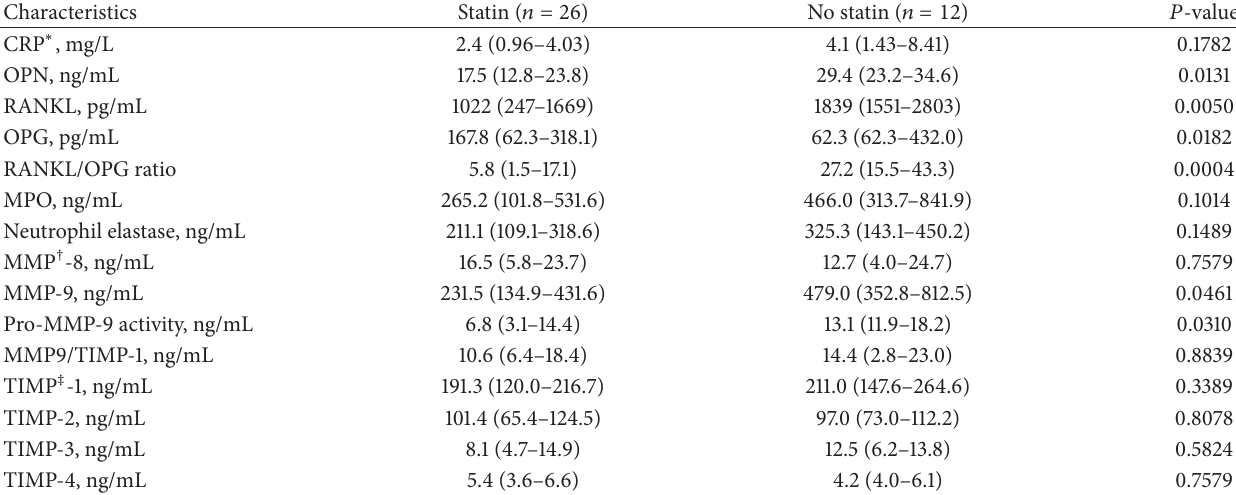
Table 4: Serum cardiovascular risk